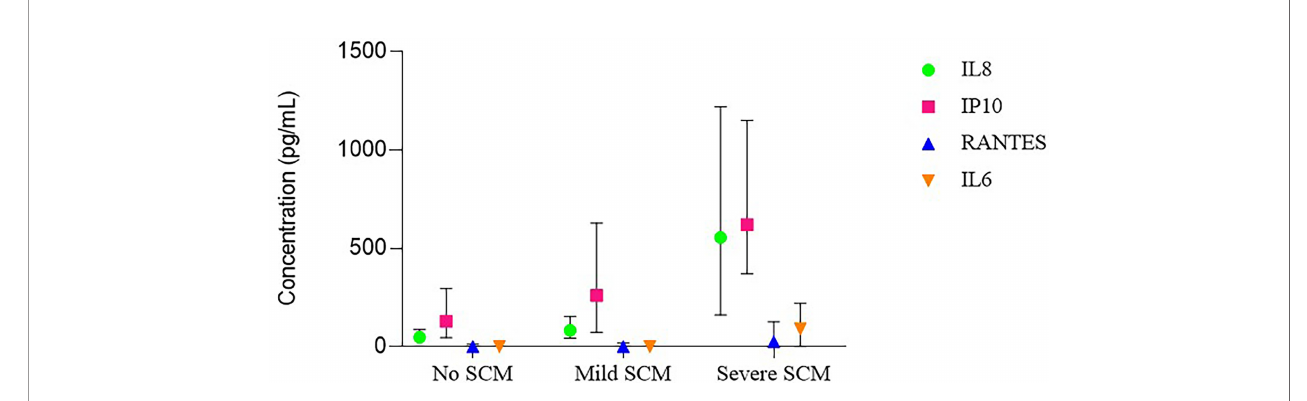
FIGURE 2 | Cytokine concentrations in milk lactoserum according to subclinical matitis